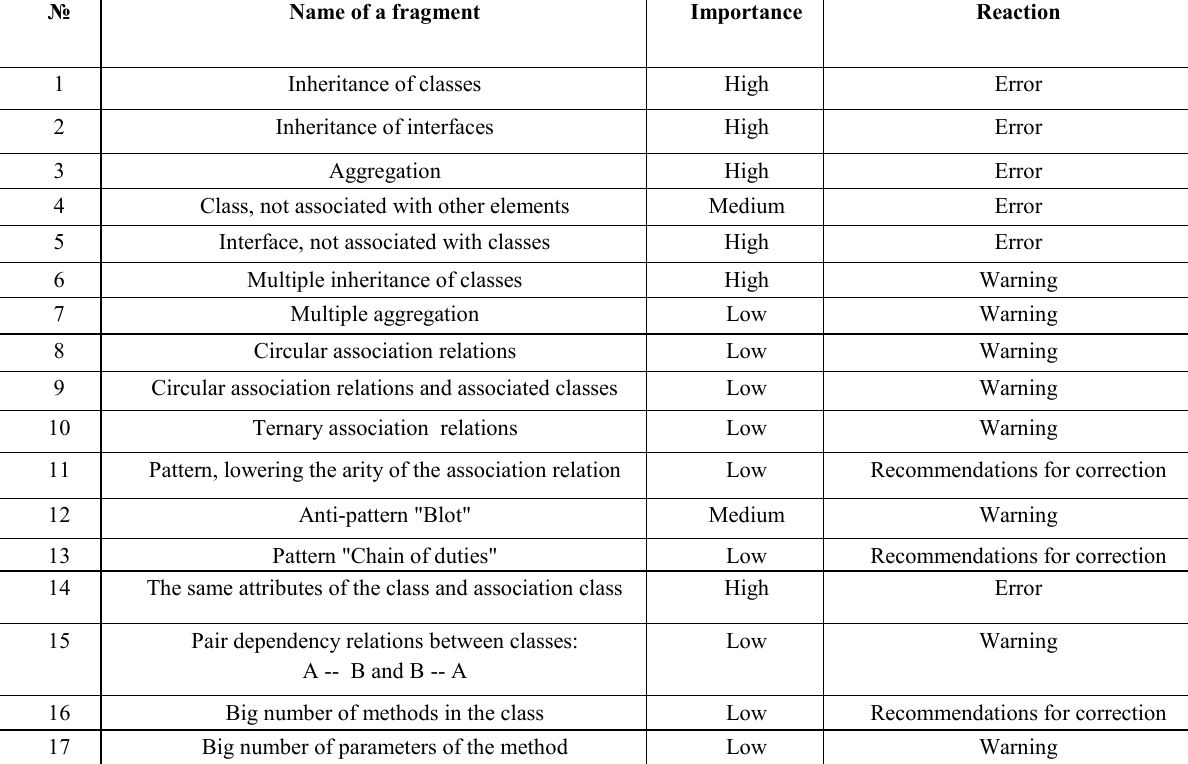
Table 1 . Typical fragments of a class diagram